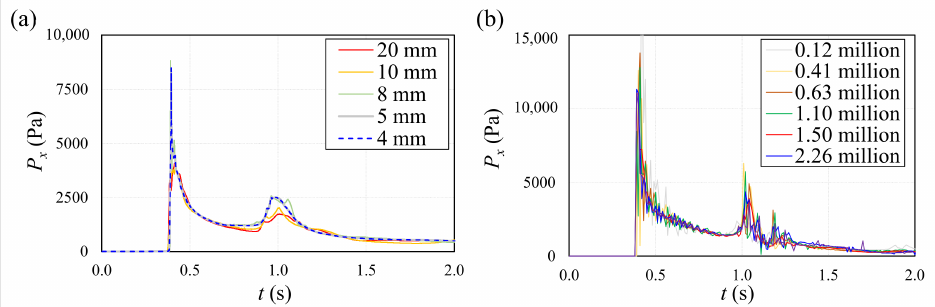
Figure 4. Numerical sensitivity study of the dynamic pressure for transducer 1 in: ( a ) OpenFOAM model ( b ) DualSPHysics